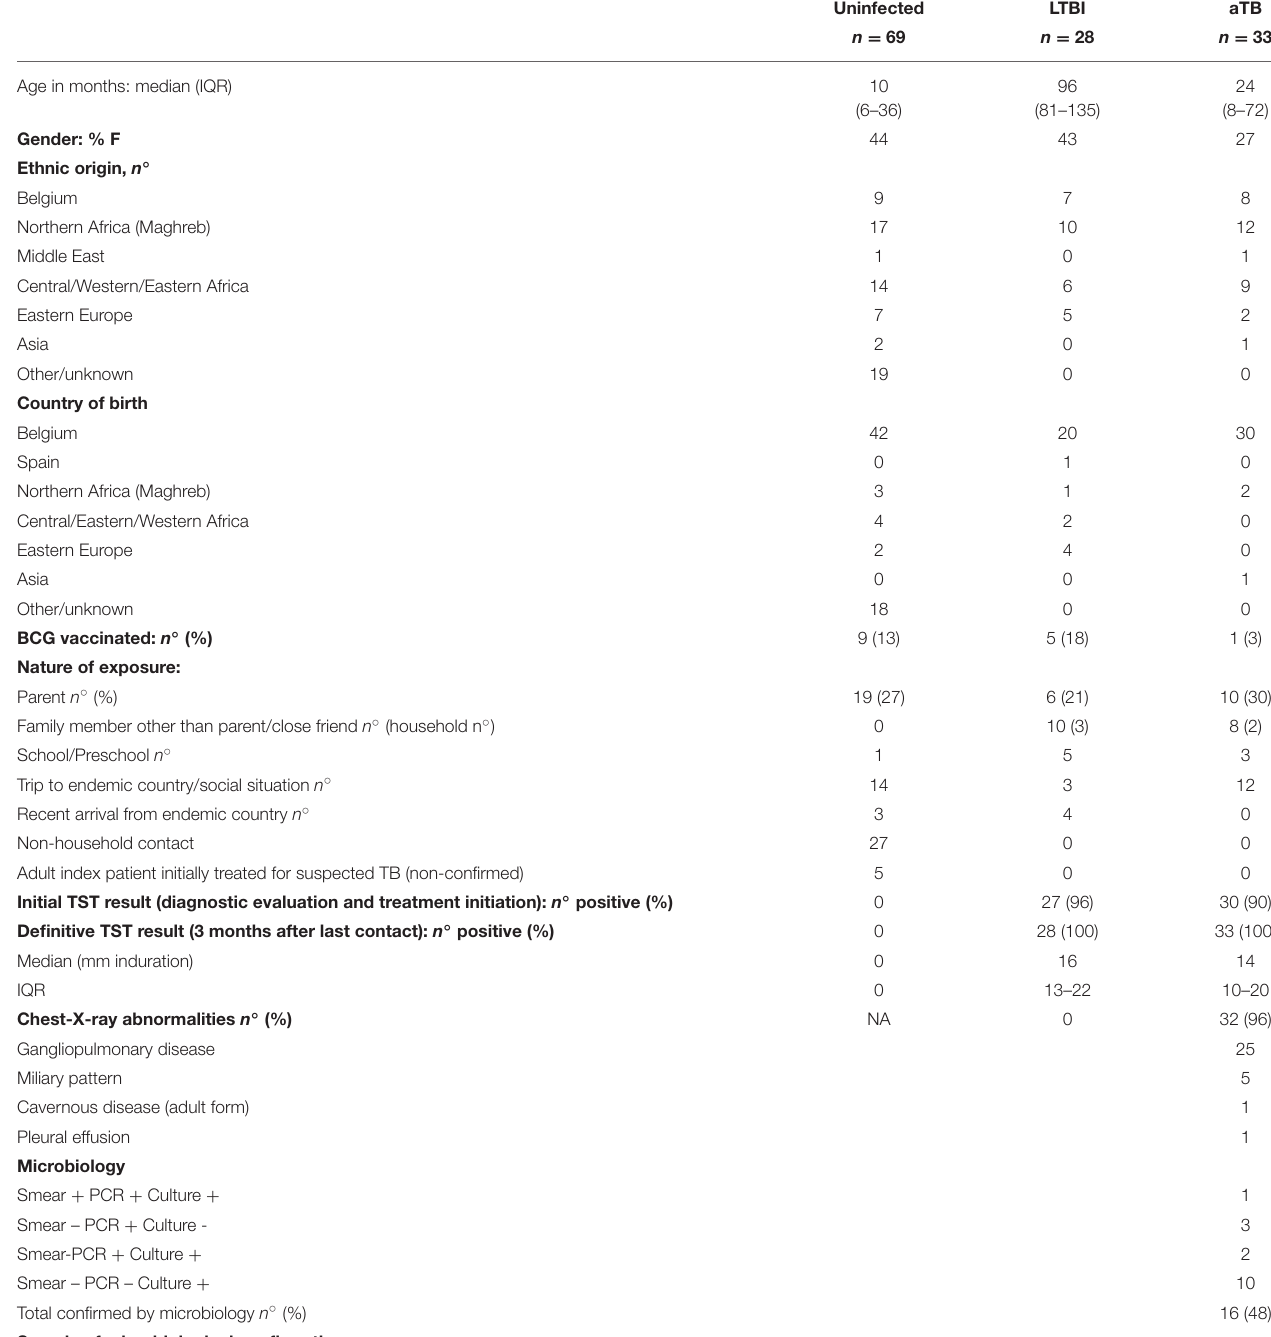
TABLE 2 | Demographic and clinical data from included